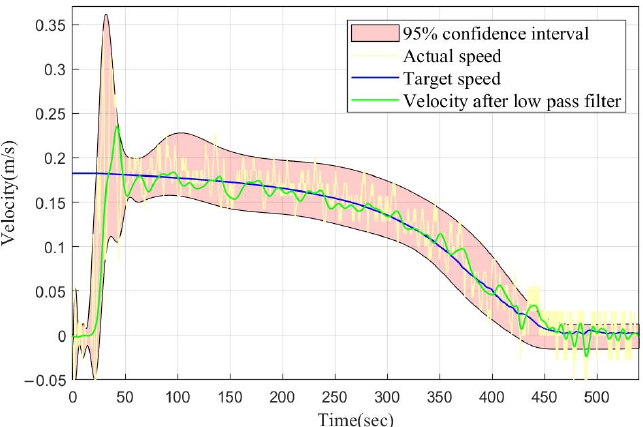
Figure 8. Field test of velocity tracking during the float descent to a depth of 60 m.